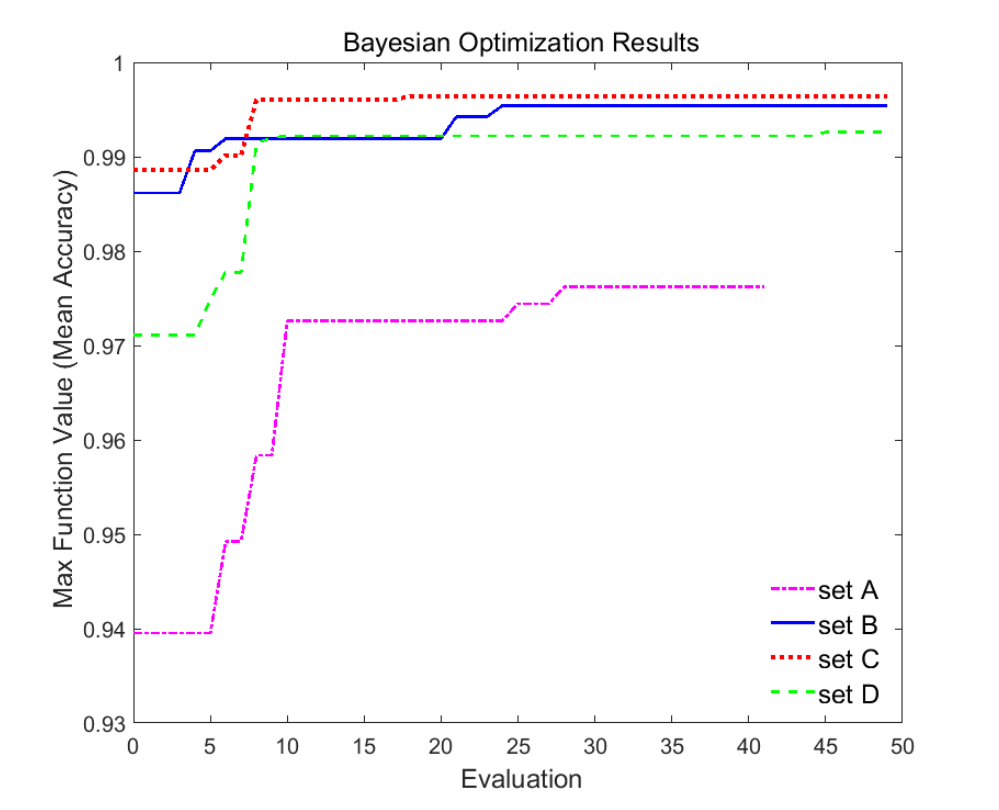
Figure 12. Bayesian optimization results for data